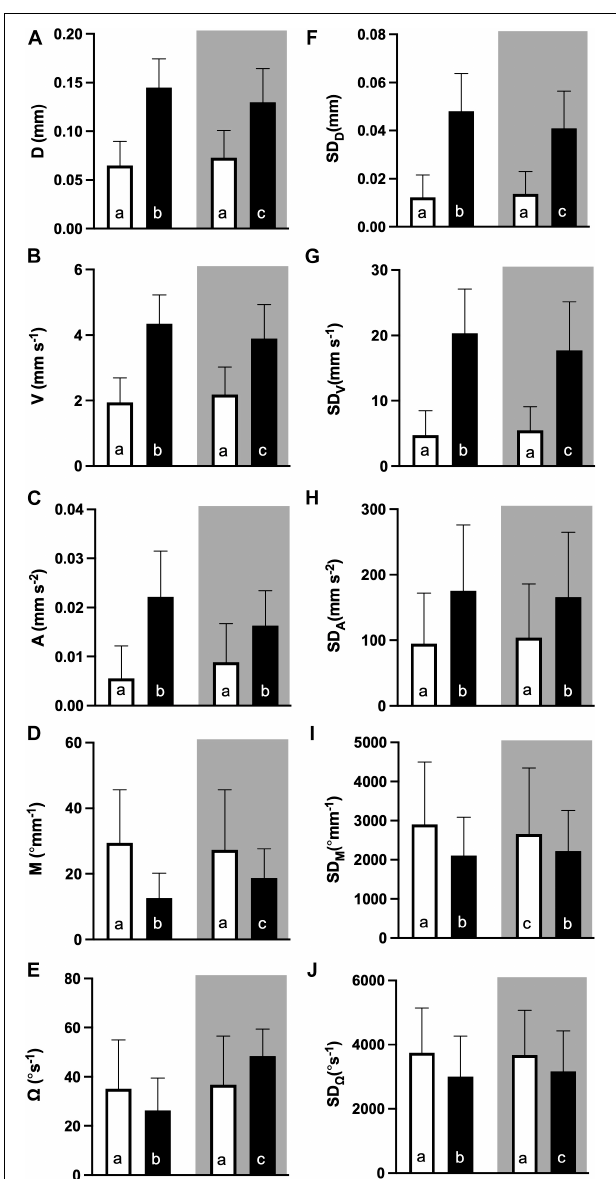
FIGURE 6 | Parameters for swimming behaviour during the light dark challenge assay: (A) distance moved (D, mm), (B) velocity (V mm s − 1 ), (C) acceleration (A mm s − 2 ), (D) meandering (M, ◦ mm − 1 ), and (E) angular velocity ( (cid:127) , ◦ s − 1 ), and the variation thereof in standard deviation (SD, F–J ), for the light (white bars) and dark (black bars) challenge phase of the essay. Shading indicates hatching during night time (dark shaded) and day time (not shaded). All values are mean ± SE. Letters indicate significant difference (RM Two-way ANOVA with Geisser-Greenhouse corrections, time of the day and phase as factors, Sidack’s post hoc test, p < 0.05, N =